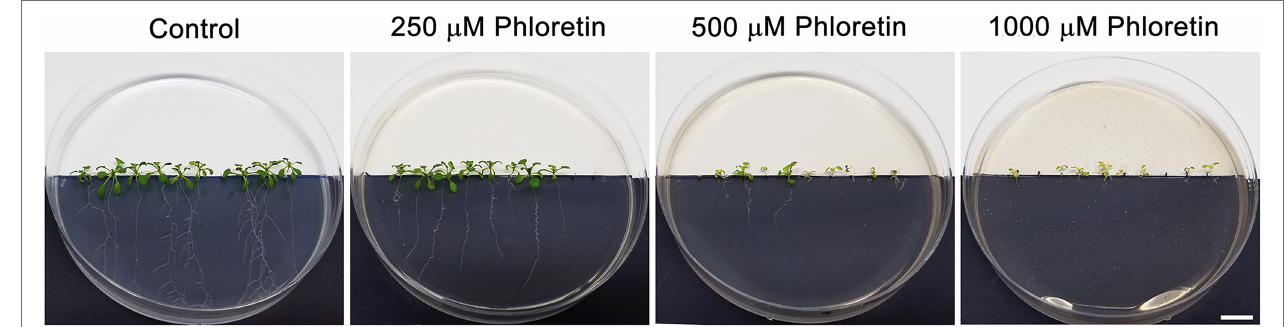
FIGURE 2 | Morphology of control and phloretin-treated Arabidopsis [ Arabidopsis thaliana (L.) Heynh.] Col-0 seedlings. Figures represent 15 days after germination (DAG)-old seedlings grown vertically on the control and phloretin-enriched medium (250, 500, and 1,000 μ M). Bar, 10